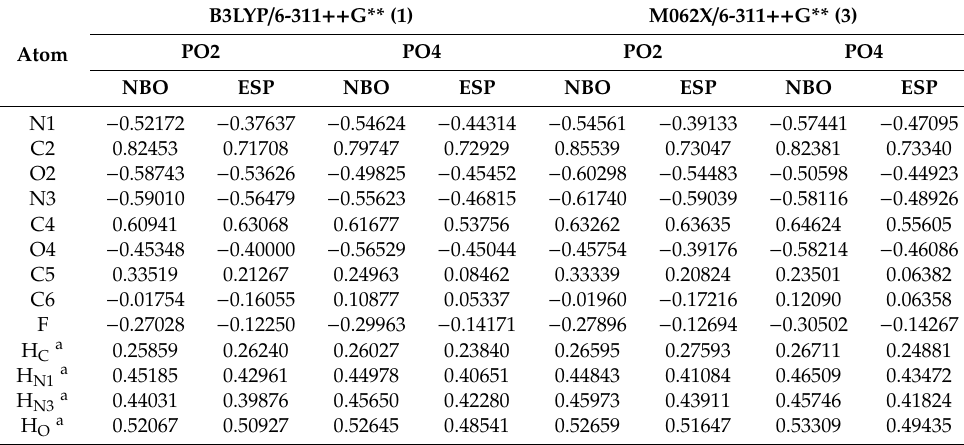
Table 4. The charge distribution in PO2 and PO4 cations from NBO and ESP